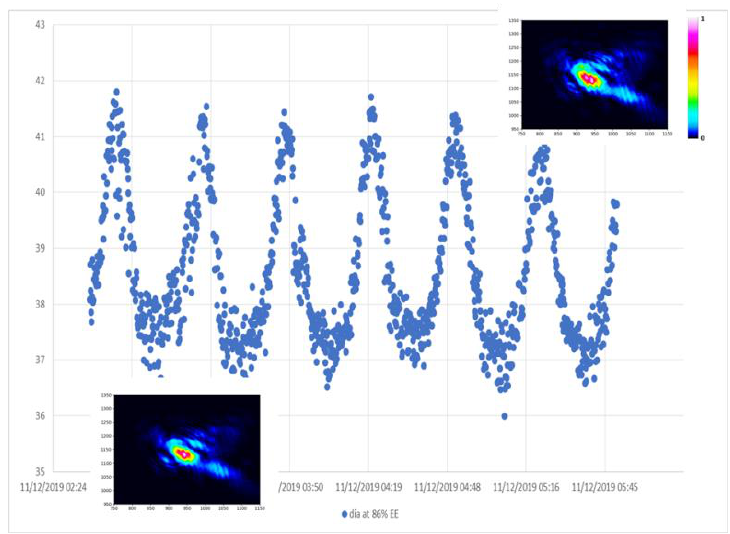
4 of 15 Figure 9. Far field measurement results during EDC; the variation of beam divergence ( right scale ) is measured and av- eraged for various EBEX temperatures (thermistor readings on the ( left scale )). The yellow diamonds indicate averaged divergence measurements at 86% encircled energy, with associated camera acquired far field pattern images overlaid. The blue circles and green squares indicate averaged measurement, in x and y, of angular width at 1/e 2 of maximum. The solid